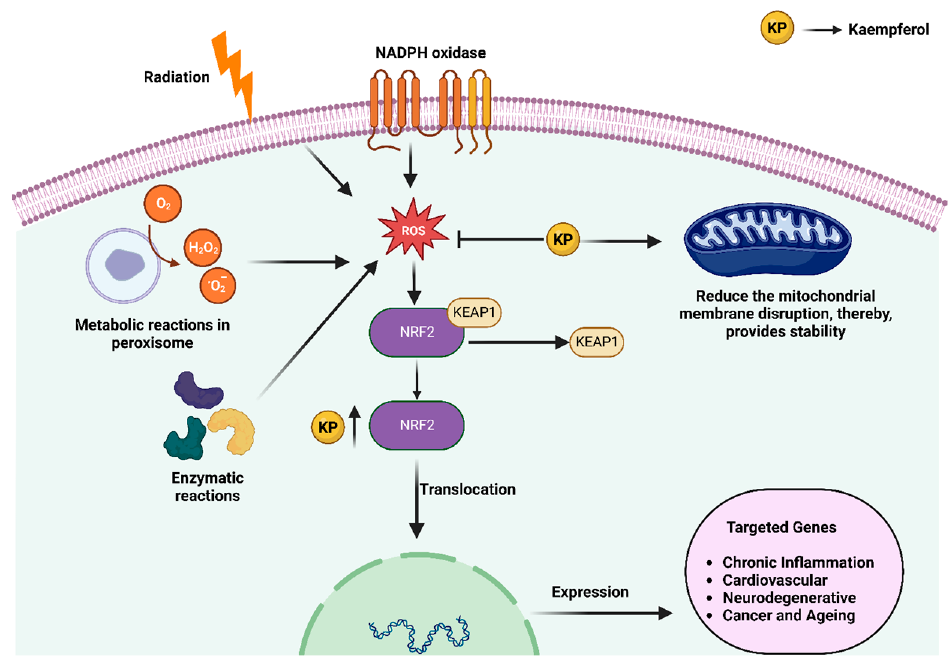
Figure 2. Antioxidant mechanisms of action of kaempferol [13]. Created using BioRender.com (accessed on 10 April